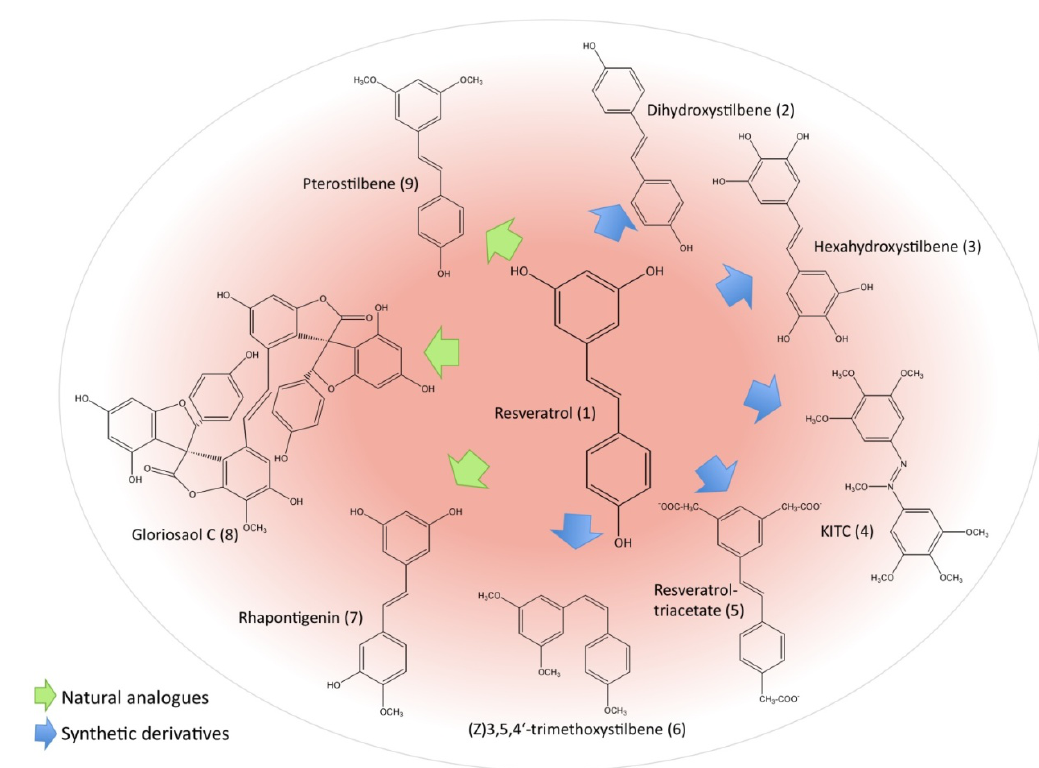
Figure 2. Reseveratrol and